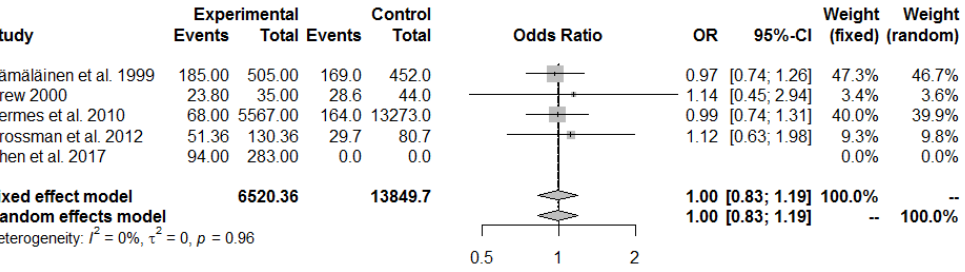
Figure 4. Pulled ORs of pain in the lumbar spine in fighter pilots vs. transport pilots. Study shows